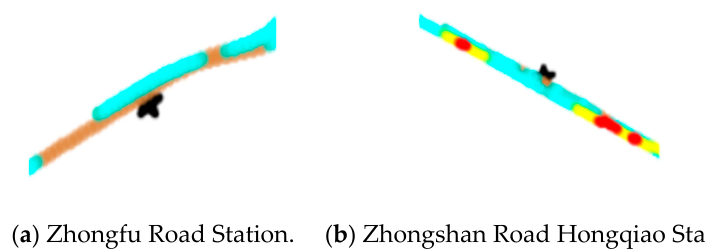
Figure 12. Detailed heat scatter plot of improper stopping at some bus stations (represented as “*”) of a high speed of the first trip in the morning.